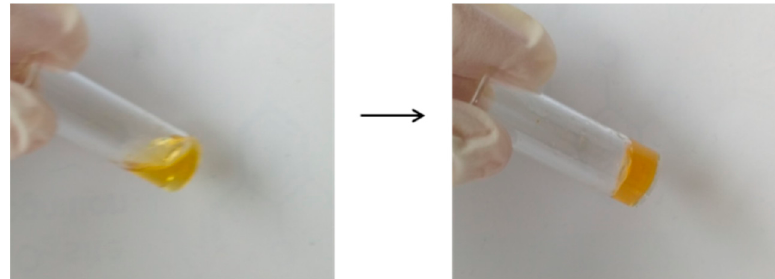
Figure 3. Images of the polymer solution before and after cross-linking.